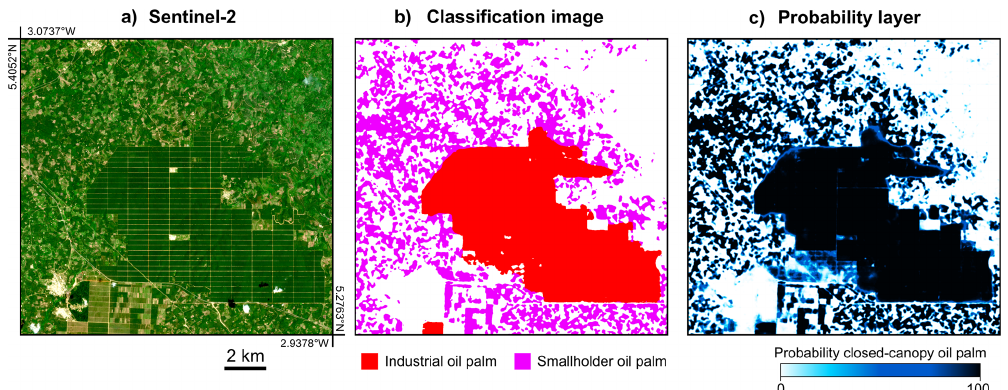
Figure 4. Example of the global oil palm layer in Côte d’Ivoire. Panel (a) shows a Sentinel-2 true color image. Panel (b) shows the resulting classification image obtained with a convolutional neural network (CNN). The classification image depicts an industrial plantation (red) surrounded by smallholder plantations (purple). The CNN learns contextual information, such as the rectilinear road network in the industrial plantation, which is noticeable in the Sentinel-2 composite. Panel (c) shows the probability of closed-canopy oil palm. The probability layer was generated from the second-last layer of the CNN which reflects the probability of each class (image source: Copernicus Sentinel data